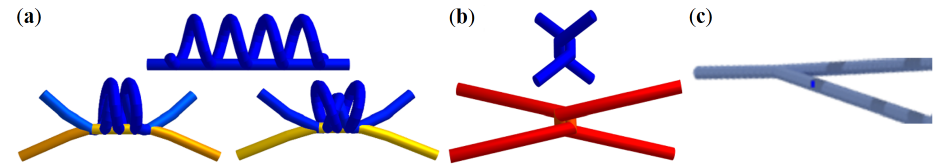
Figure 12. Representative winding/branching elements in leather meshes: ( a ) a coiled knot with ( left ) high and ( right ) low friction; ( b ) a simple contact interaction; and ( c ) typical Y-branching node. At low friction, bending or compression of the material does not influence the torsion at the contacts (see [25,26] for theoretical justification). Exceptions are knots (Figure 12a, right). If the contribution of torsion to the effective properties of the fibrous material is results of Section 3.2).